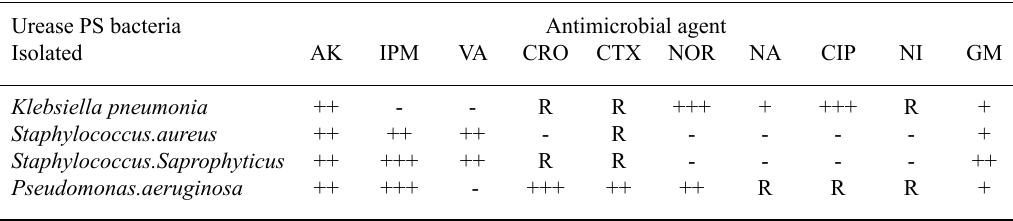
table 5. Antibiotic sensitivity test